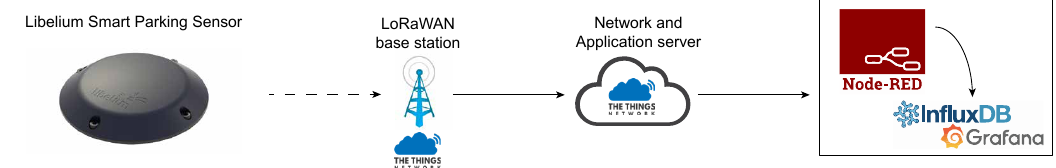
Figure 1. Network architecture of Libelium Smart Parking sensors.